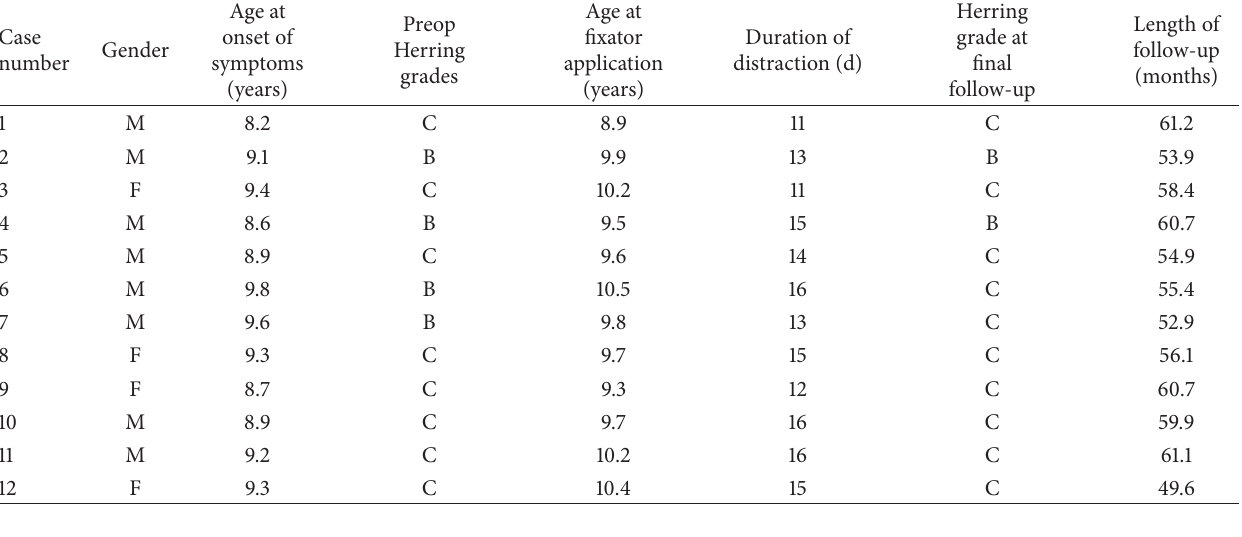
Table 1: Demographic characteristic of patients.